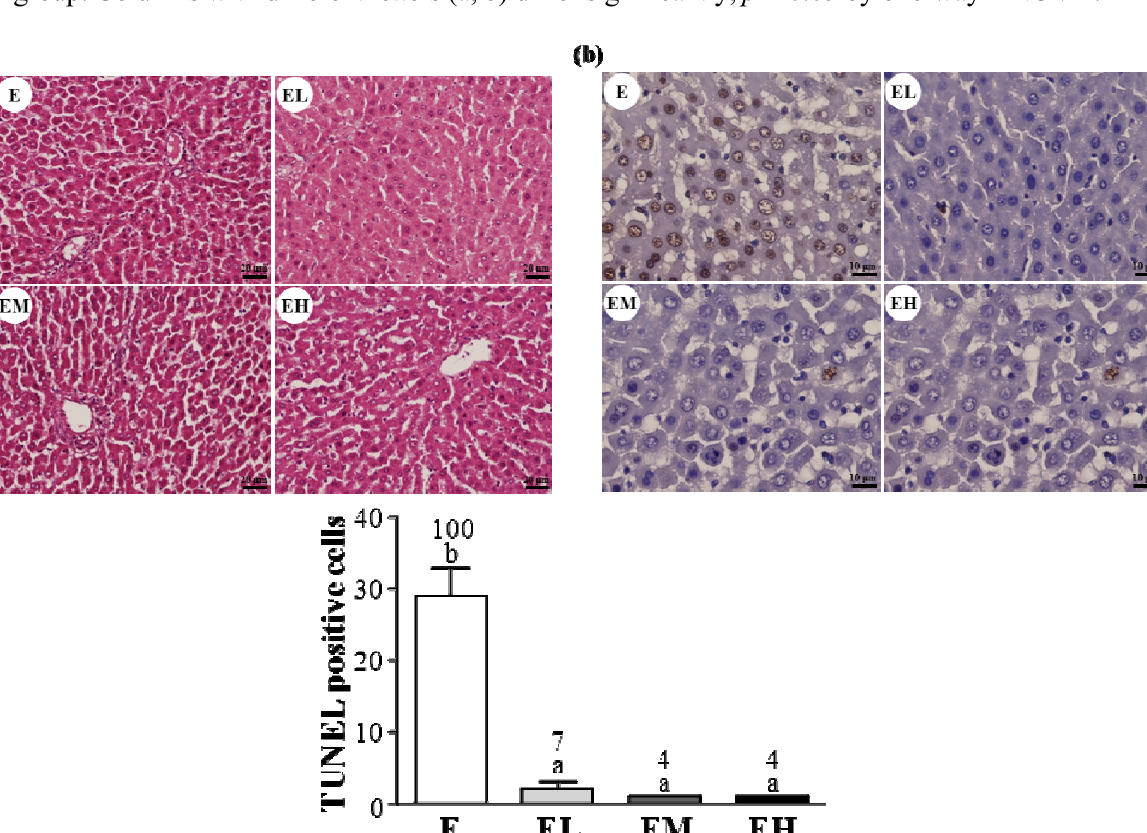
Figure 2. The G. tsugae supplement anti-apoptotic effect on liver tissues after